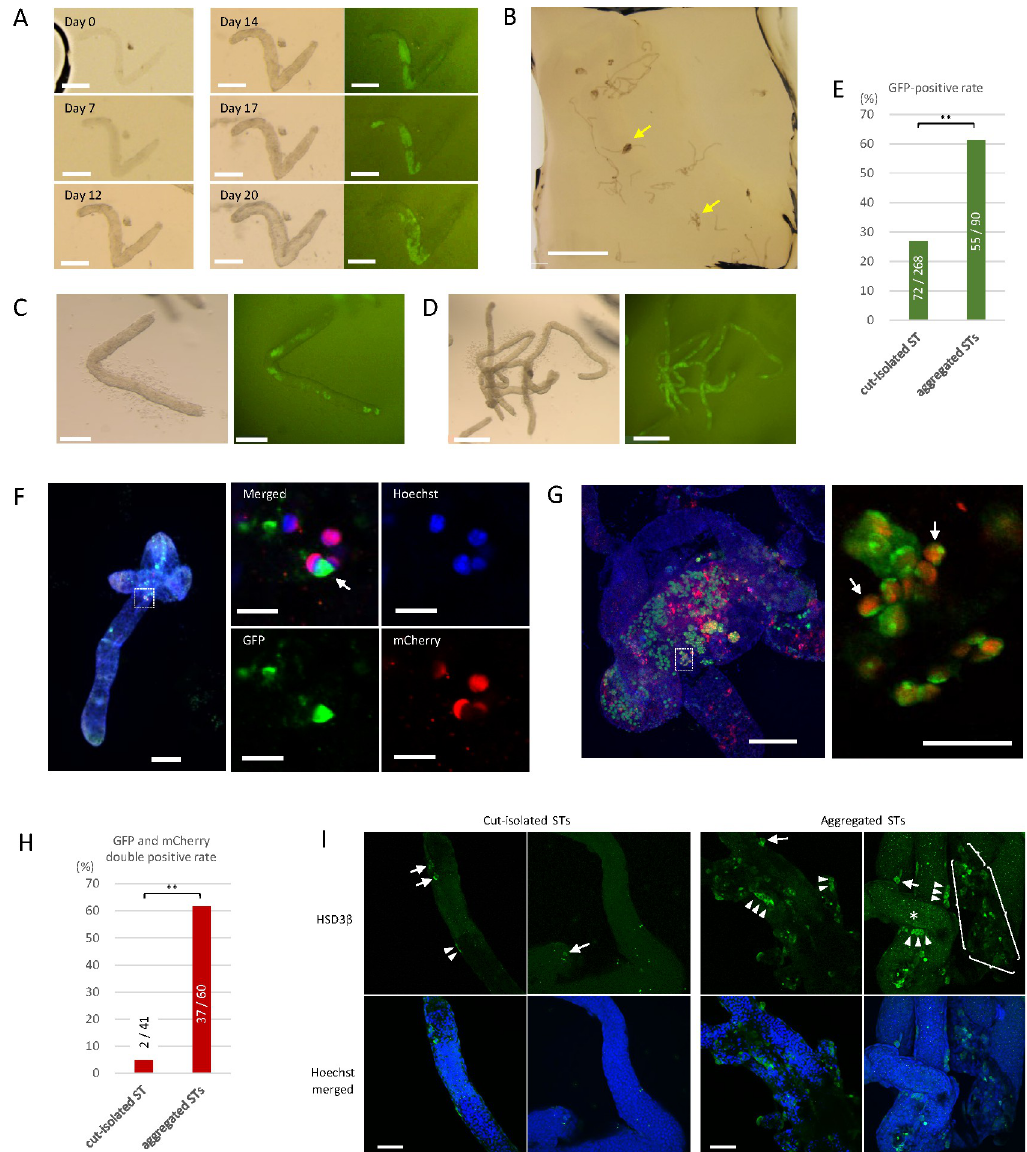
Fig 3. Culture of cut-isolated and aggregated STs in the soft agarose. (A) Series photos of a cut-isolated ST embedded in soft agarose using method B, showing the maintenance of its form without shrinkage and the induction of GFP expression from day 14. (B) Low-magnification view of cut-isolated STs embedded in the soft agarose. Yellow arrows indicate aggregated STs. (C) A cut-isolated ST in the soft agarose with GFP expression at culture day 22, derived from a 7 dpp mouse testis. (D) Aggregated STs in the soft agarose with GFP expression at culture day 22, derived from a 7 dpp mouse testis. (E) GFP expression was examined by fluorescence microscopy in samples from 7 experiments and assessed during culture days 20 to 25. Numerators and denominators in or over each bar are the numbers of GFP-positive tissue samples and total examined tissue samples, respectively. The experiments were performed under a 20% O 2 concentration. ** P < 0.01. (F) Whole-mount immunostaining of a cut-isolated ST with anti-GFP antibody (green) and anti-RFP antibody (red). Nuclei were counterstained with Hoechst 33342 dye (blue). The box indicated by the dotted lines in the left panel is enlarged in the right panels. Germ cells with both GFP and mCherry expressions, indicating elongating spermatids at or beyond the step 11, were observed (white arrow). (G) Whole- mount immunostaining of aggregated STs demonstrated several elongating spermatids, expressing both GFP and mCherry. The rectangular region surrounded by a dotted line is enlarged in the right panel. (H) GFP and mCherry expressions were confirmed by whole-mount immunohistochemical staining in samples from a single experiment. The tissues were fixed either on culture day 45, 52, or 59. The experiment was performed under a 20% O 2 concentration. ** P < 0.01. (I) Whole-mount immunostaining of cut-isolated and aggregated STs with HSD3 β antibody (Green), along with counterstaining with Hoechst. Within aggregated STs, faint dot-like GFP expression derived from Acr-GFP was observed ( * ). An HSD3 β signal was